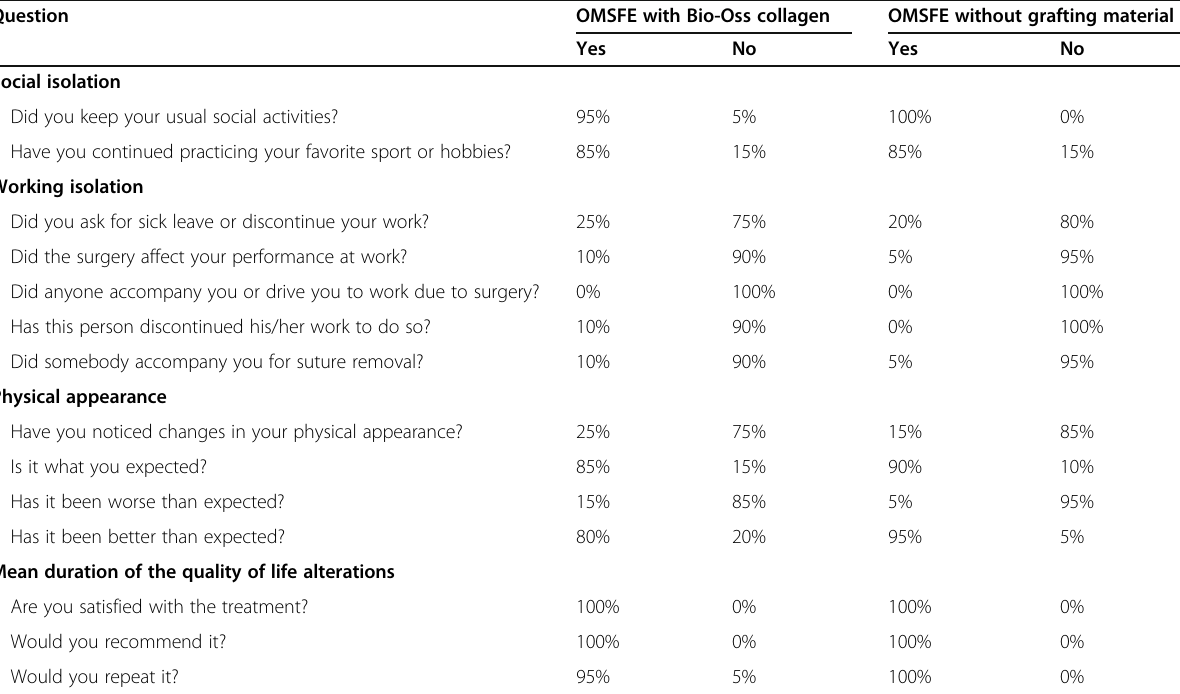
Table 4 Questionnaire assessing social and working isolation, physical appearance and quality of life alterations, at one week. Question OMSFE with Bio-Oss